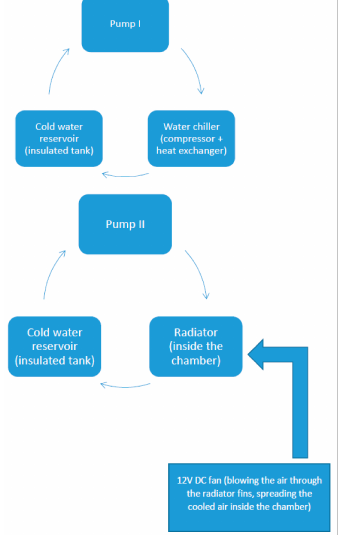
Figure 18. Graph presenting the circulation of the cooling media inside a temperature control system based on a compressor water